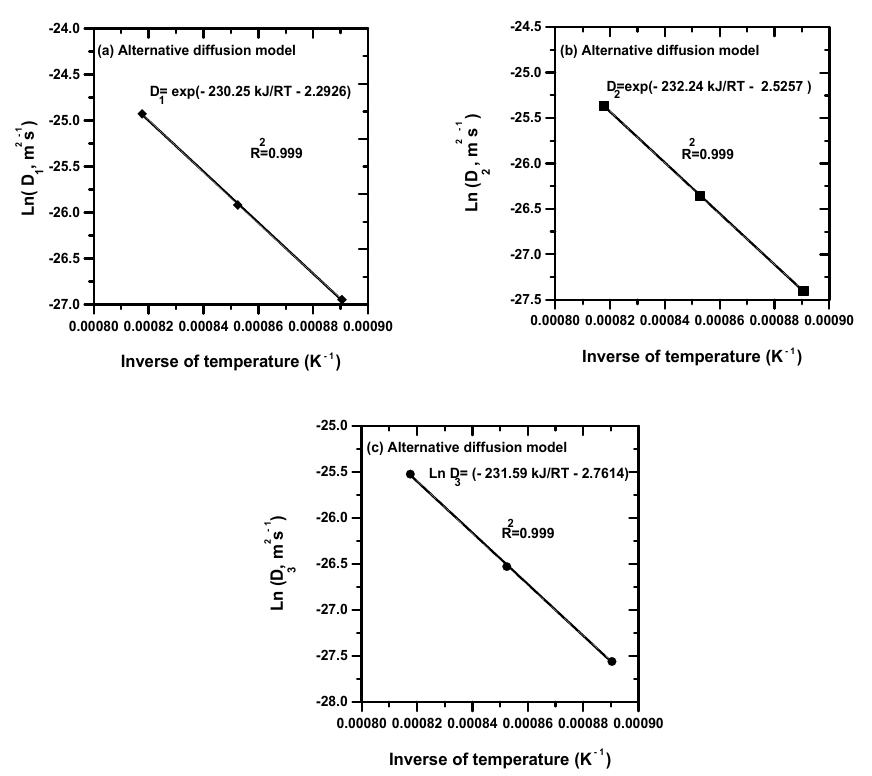
Figure 2. Arrhenius behaviors of assessed boron diffusivities in nickels borides with the alternative diffusion model. Table 4 contains the estimated values of boron diffusion coefficients in nickel borides with the mean diffusion coefficient (MDC) method. Table 4. Estimated values of boron diffusivities in nickel borides by the MDC method.